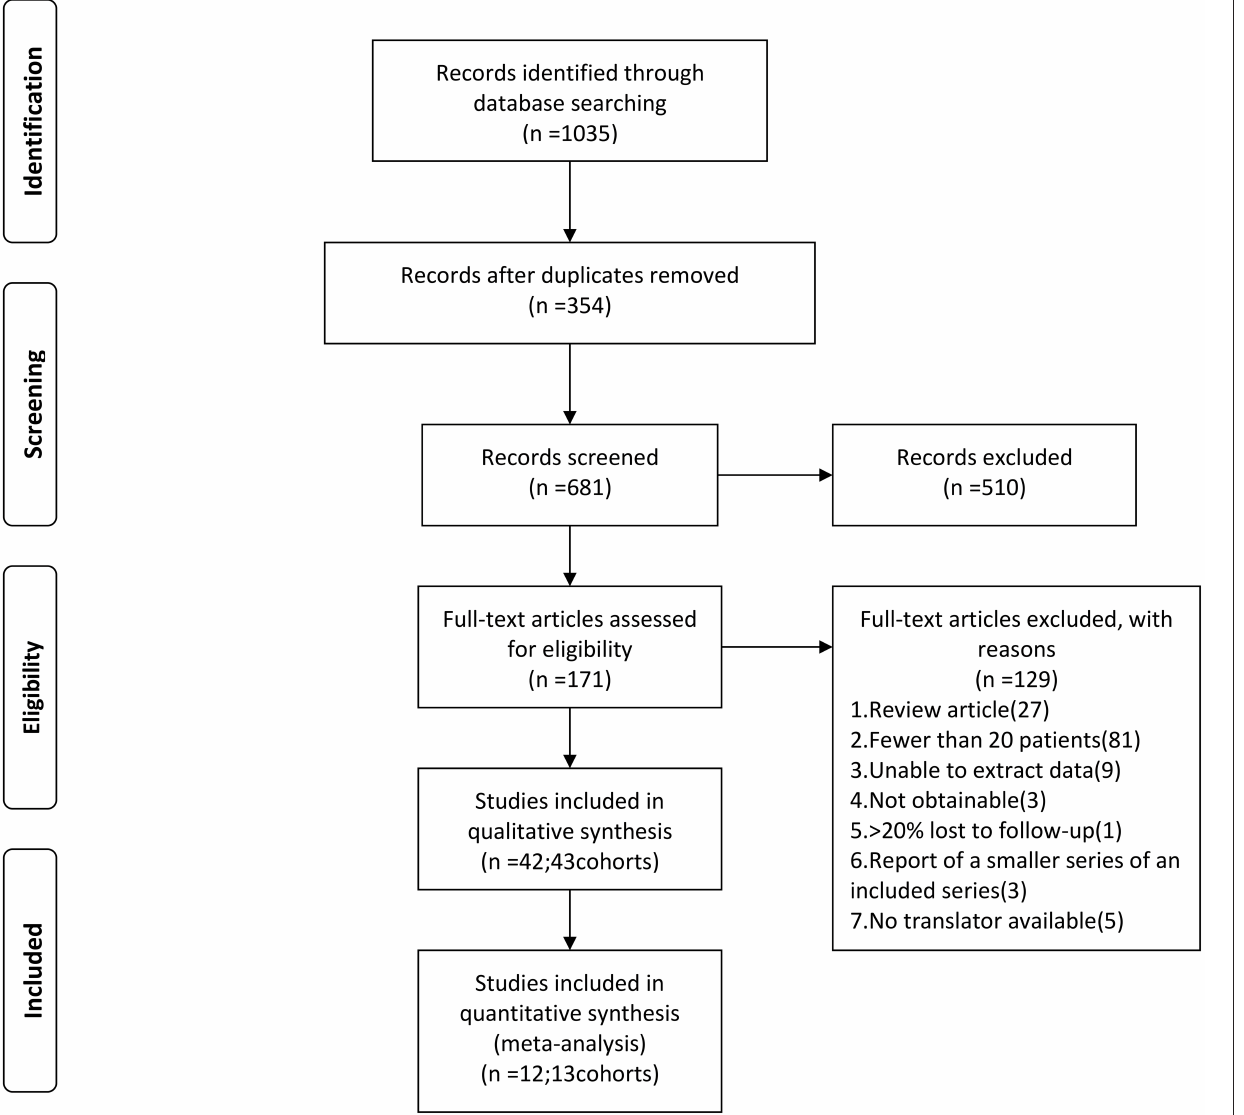
FIGURE 1 | Flow chart of the data search followed by PRISMA guidelines. PRISMA, Preferred Reporting Items for Systematic Reviews and